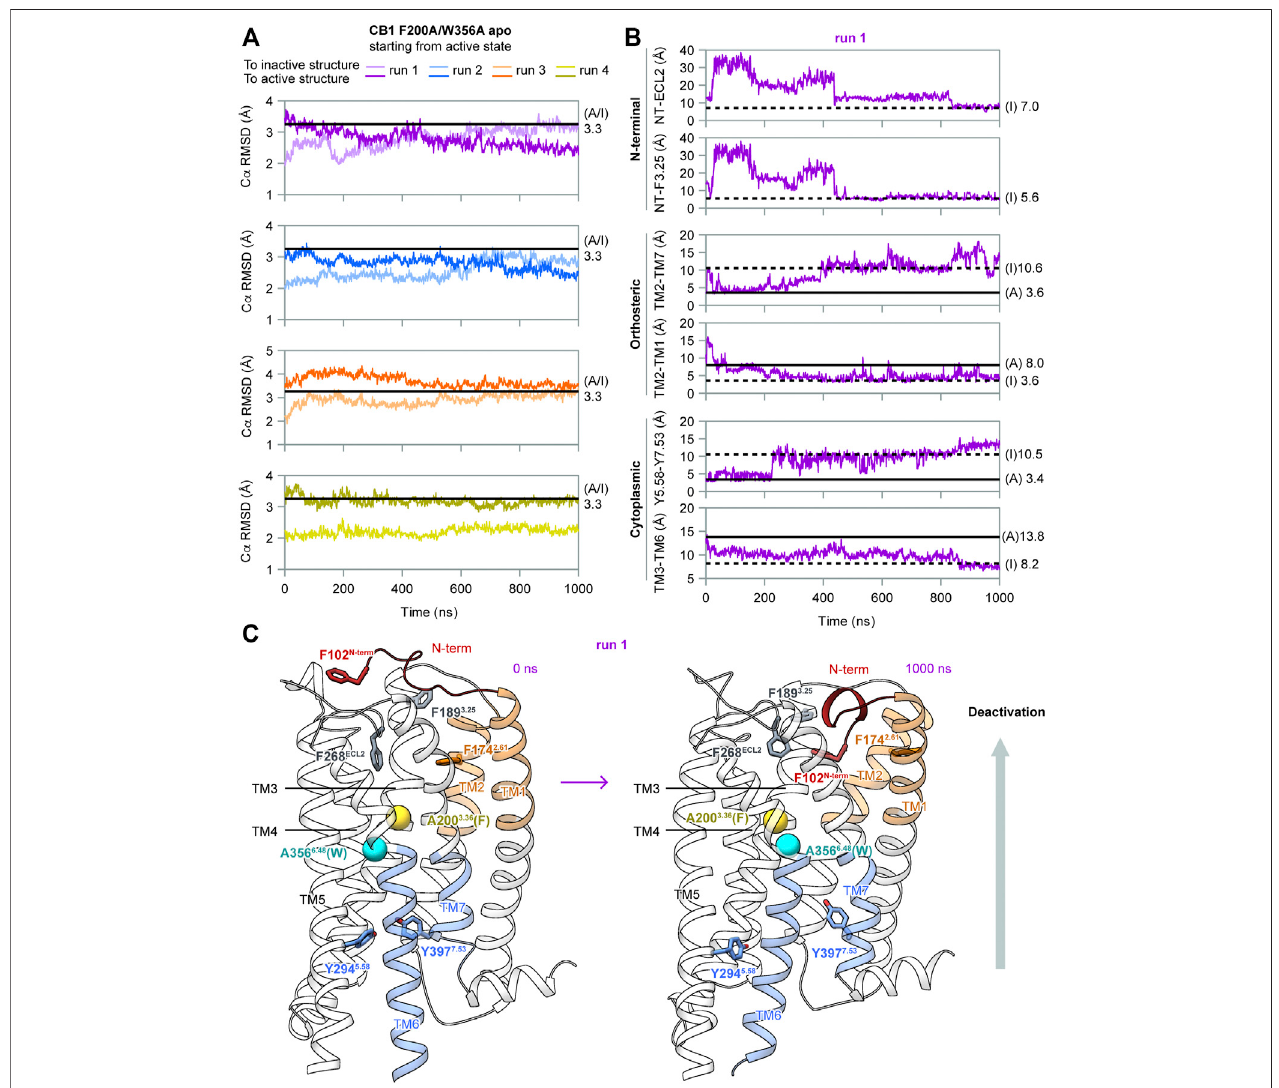
FIGURE 3 | MD simulation results of CB1 double-mutant F200A/W356A starting from the active state. (A) RMSD of C α atoms to inactive or active structures showed the overall structure gradually shifted from the active state to inactive state in runs 1 – 2. (B) Indicators for movements at different parts of CB1 in run 1, showing deactivation transitions started at the cytoplasmic end and fi nalized at the extracellular end. The two N-terminal indicators could not be measured in the active structure because F102 N − term was not solved. Results for run 2 are shown in Supplementary Figure S3 . (C) Structures of the fi rst and the last snapshot of run 1, showing conformationalchangesatdifferentpartsofCB1duringsimulation.C β atomsofA200 3.36 (phenylalanineinwildtypeCB1)andA356 6.48 (tryptophaninwildtypeCB1)are shown as